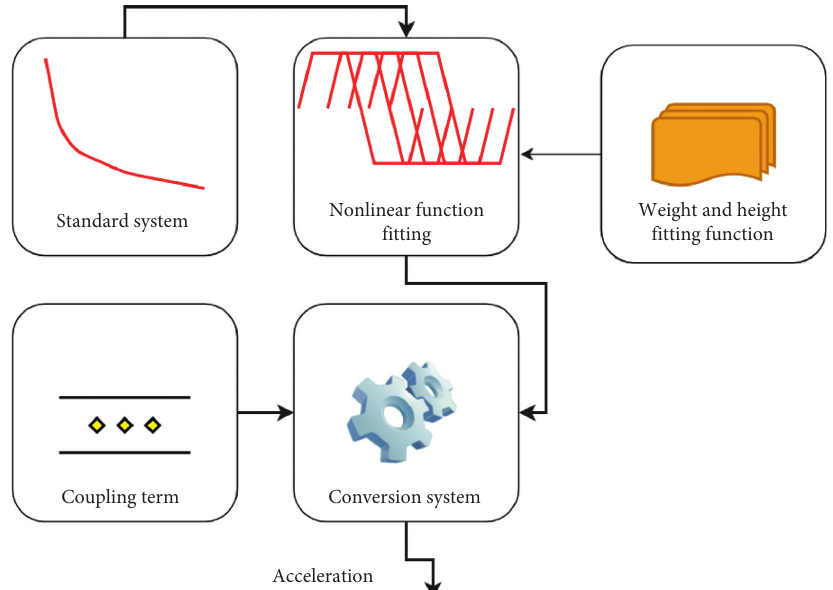
Figure 6: Block diagram of the DMP Internet of Health Things system based on step height.